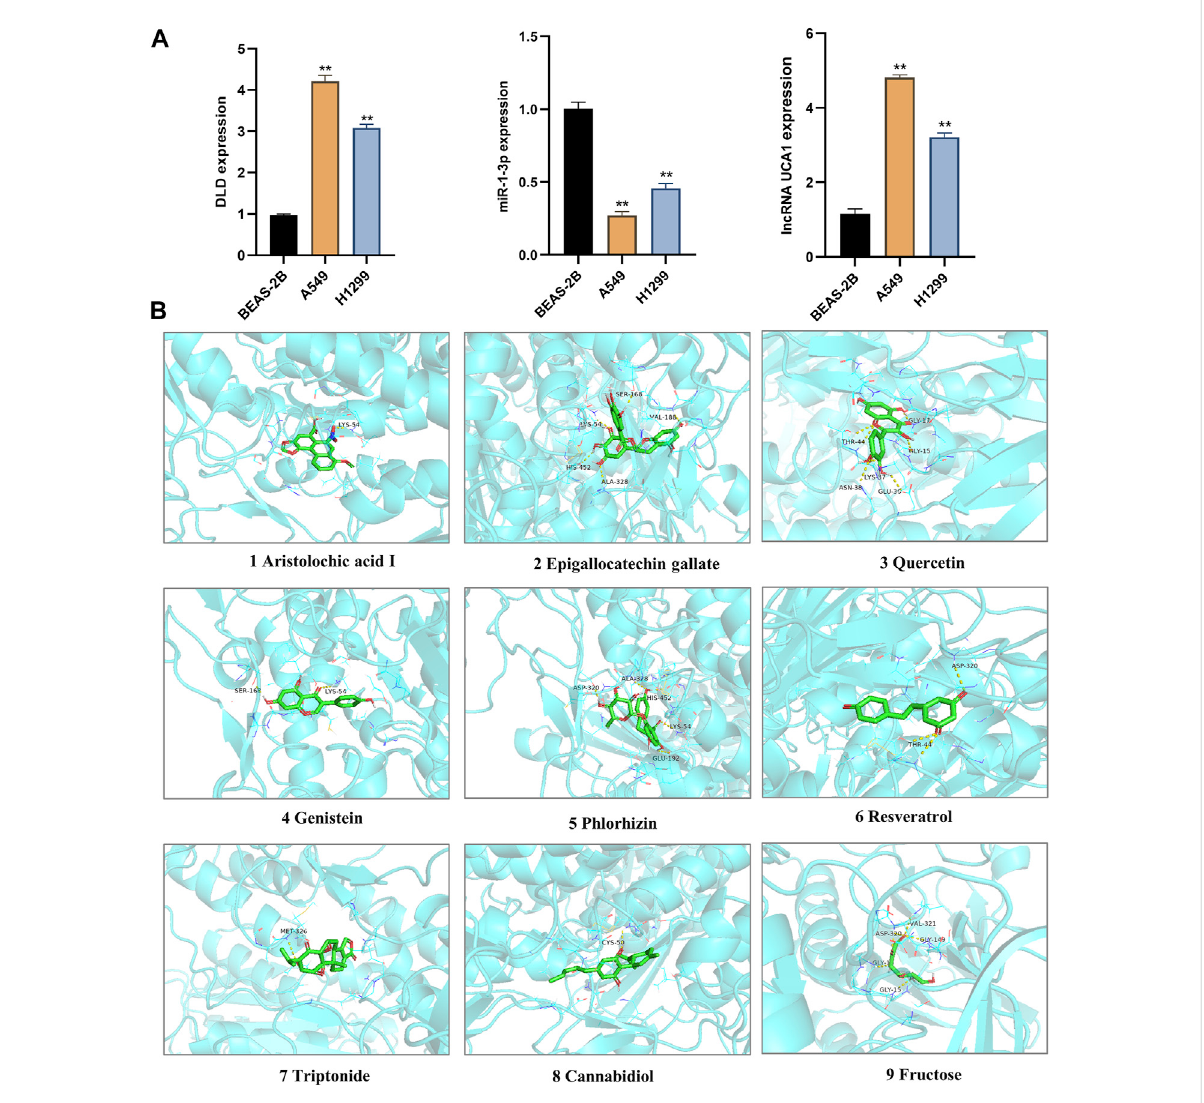
FIGURE 11 Validation of In vitro cell experiment and molecular docking. (A) The differential expression of lncRNA UCA1, miR-1-3p and DLD in normal lung epithelial cells (BEAS-2B) and different LUAD cell lines (A549 and H1299) were detected by in vitro cell experiments. **, p < 0.01. (B) The interaction between nine TCM active components and DLD protein was simulated by molecular